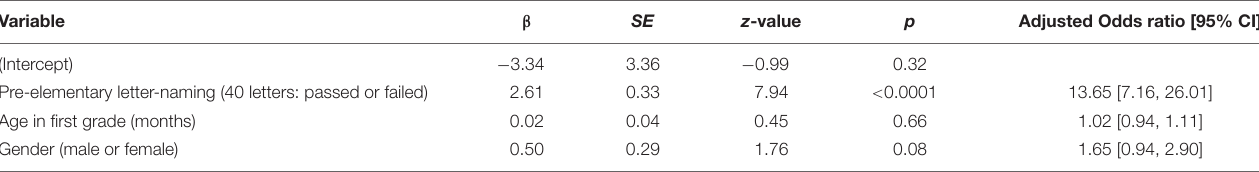
TABLE 3 | Final model of binomial logistic regression.